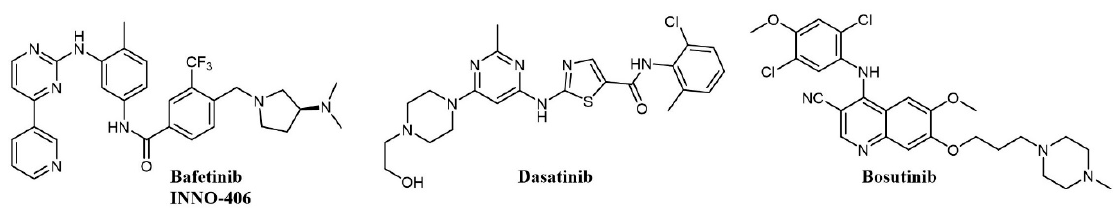
Figure 6. Chemical structure of dual SRC/ABL inhibitors used for chronic myelogenous leukemia (CML) treatment. Bosutinib (SKI-606, Bosulif; Figure 6), also a dual SRC-ABL inhibitor, binds